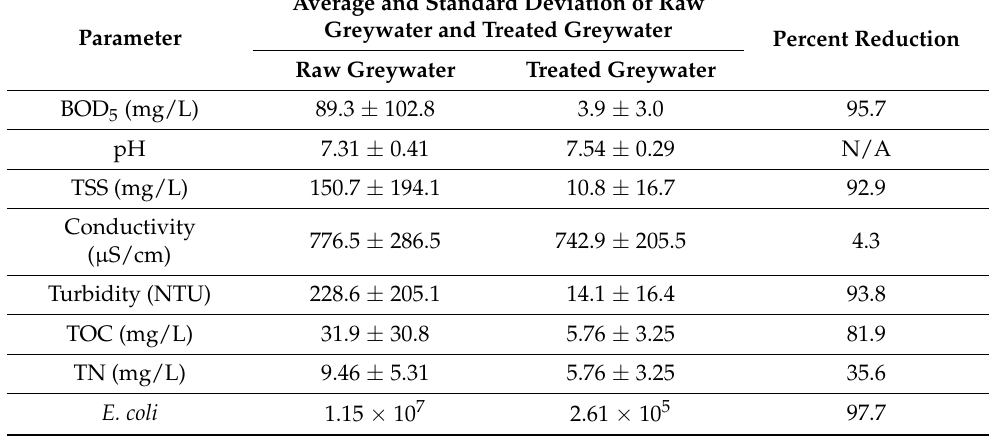
Table 2. Water quality parameters for raw and treated greywater in the CWs with the corresponding percent